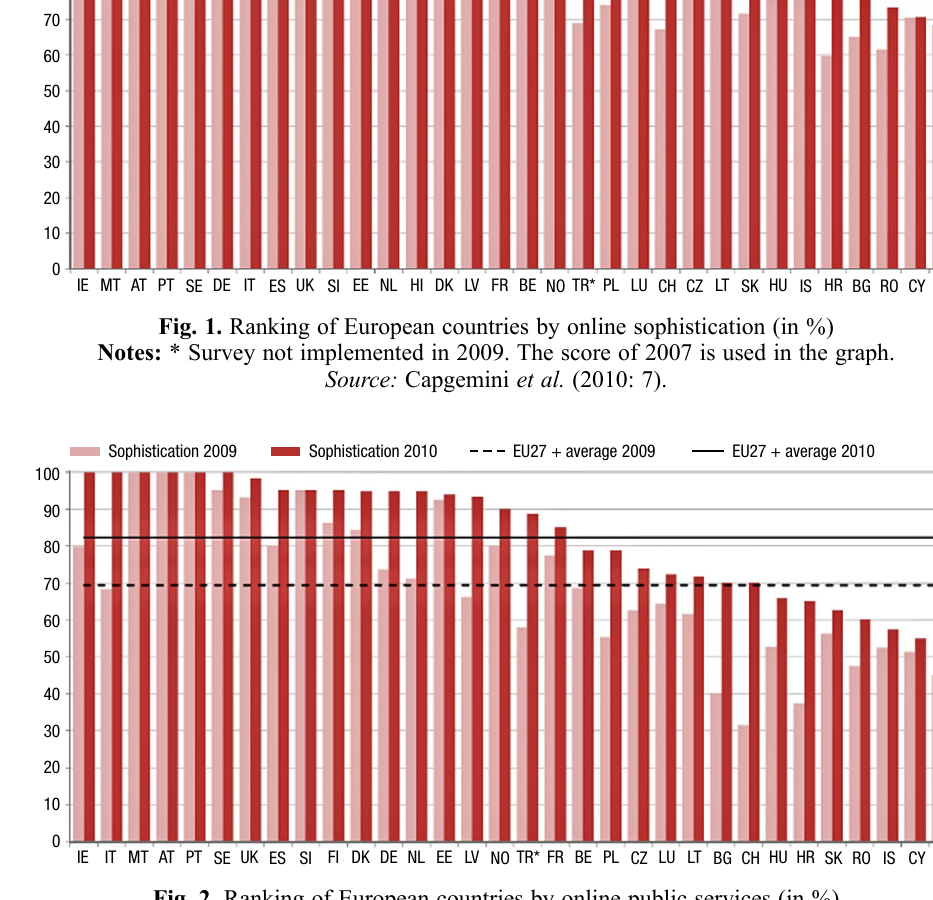
Fig. 2. Ranking of European countries by online public services (in %) Notes: * Survey not implemented in 2009. The score of 2007 is used in the graph. Source: Capgemini et al. (2010: